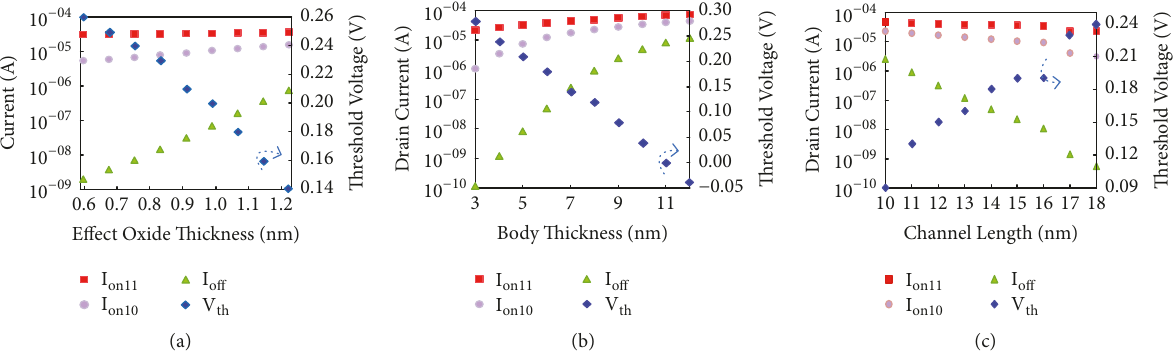
Figure 3: The trend of the drain current versus (a) EOT, (b) TSI, and (c) L.